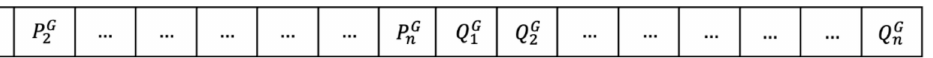
Figure A1. GA chromosome